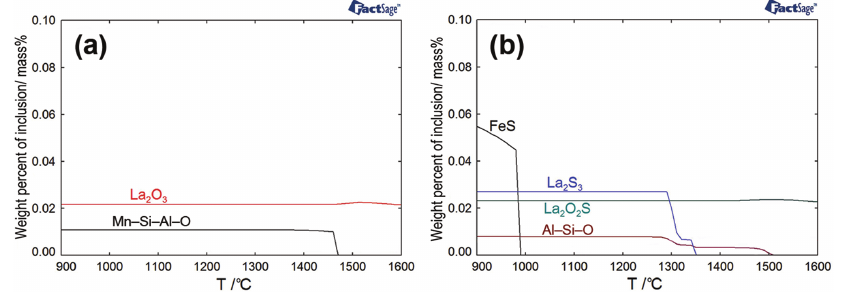
Figure 6: Calculated equilibrium weight percent of inclusions in steels (a) MN4 and (b)